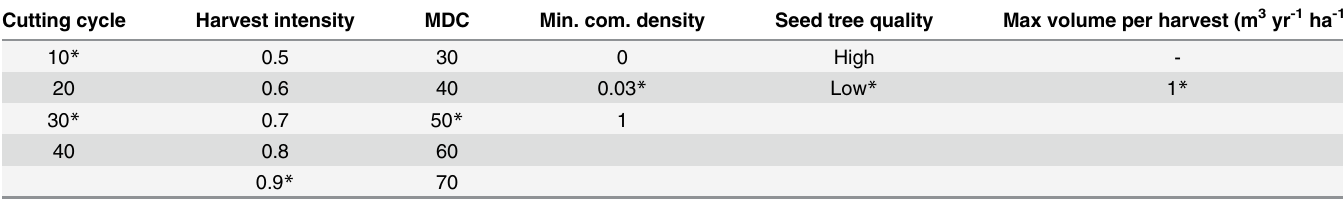
Table 2. Values for management criteria used in management